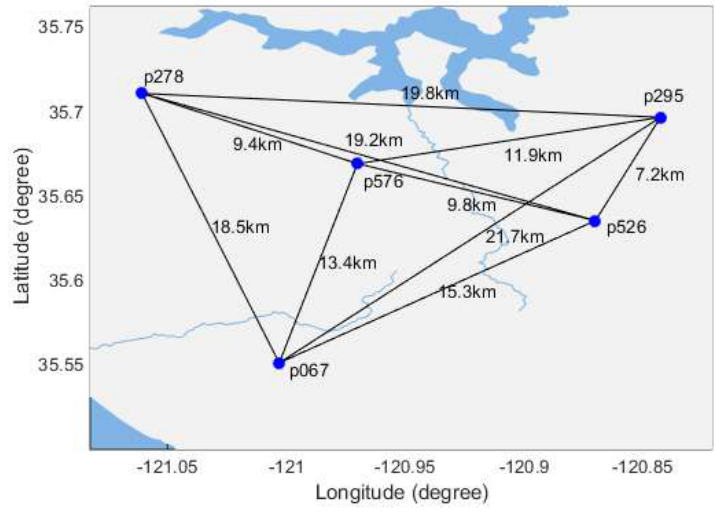
Figure 7. The distribution of the CORS stations. Figure 7 . The distribution of the CORS stations.